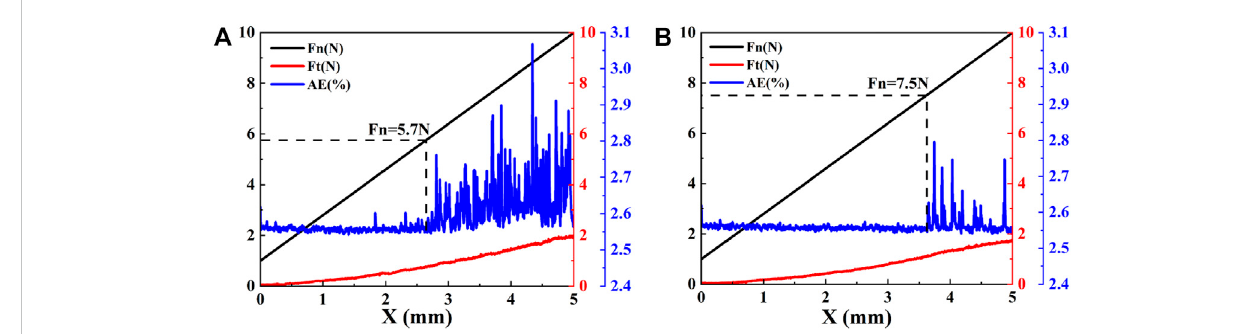
FIGURE 6 The scratch data of PI surface treated by carbon plasma with different graphite target currents: (A) 2.5 A (B) 3.0 A.